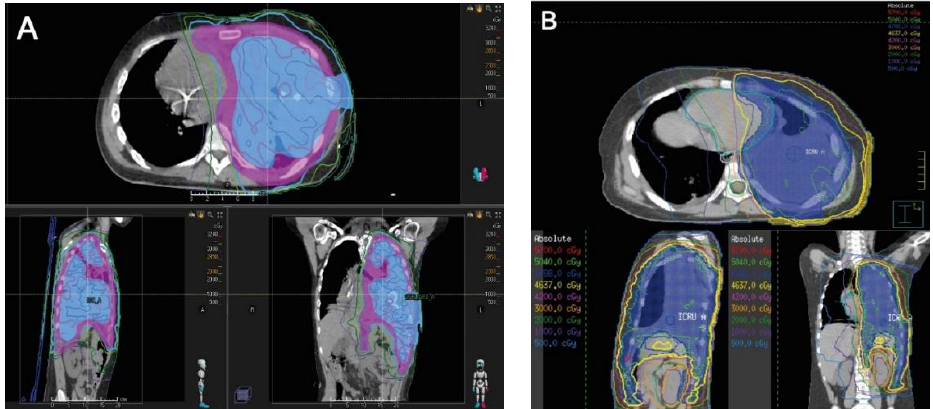
Figure 1. High-resolution images of the radiotherapy plans of one representative patient that received preoperative RT and one representative patient that received postoperative RT. ( A ) High-resolution images of Patient 4 who received pre-operative hemithorax RT for synovial sarcoma. A simultaneous integrated boost plan was created; 25 Gy in 5 fractions was prescribed to the entire pleural space (in magenta colorwash), while a dose of 30 Gy in 5 fractions was prescribed to the gross tumor (in blue colorwash). The thin colored lines represent regions receiving at least the dose noted in the legend; for example, the thick magenta line represents regions receiving at least 28.5 Gy, while the thick light blue line represents regions receiving at least 23 Gy. Please note the RT plan minimizes dose to the contralateral right lung. ( B ) High-resolution images of Patient 5 who received post-operative hemithorax RT for Ewing sarcoma. The planned dose was 50.4 Gy in 28 fractions to the entire pleural space (in blue colorwash). The thin colored lines represent regions receiving at least the dose noted in the legend. Similar attempts were made to minimize dose to the contralateral lung.